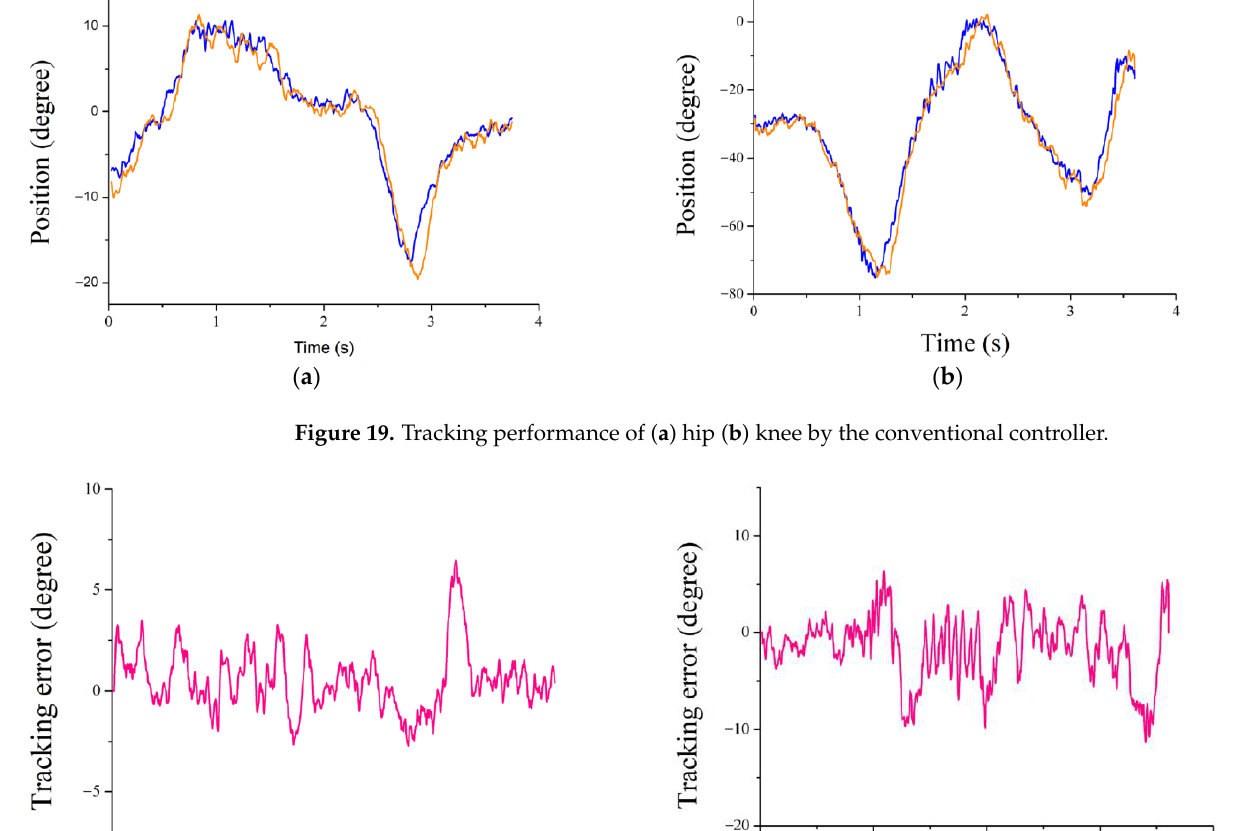
( b ) Figure 22. ( a ) Tracking performance of the knee by the self-tuning controller; ( b ) controller gains of the knee by the self-tuning controller. ( a ) ( b ) Figure 23. Tracking error of the ( a ) hip and ( b ) knee by the self-tuning controller.